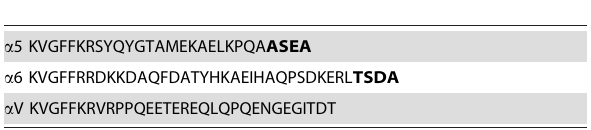
Table 1. Amino acid sequences of Xenopus a integrin cytoplasmic